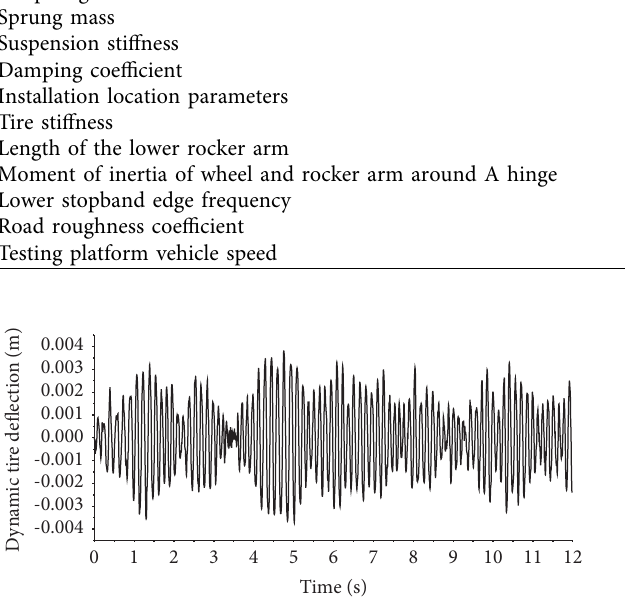
Figure 8: Time-domain plot of the dynamic tire deflection.